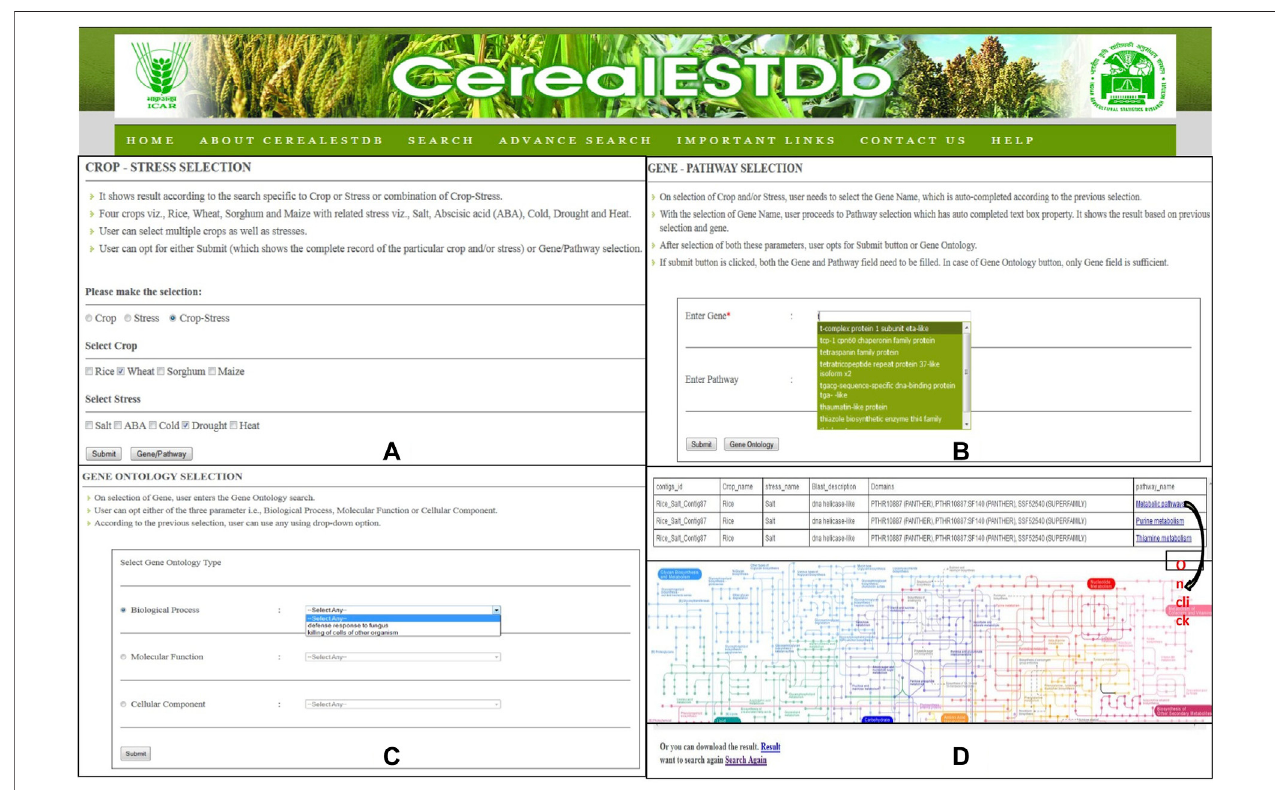
FIGURE 6 | Details of Search Options in CerealESTDb (A) Crop-Stress Selection page with options of select either crop or stress or combination of both (B) Gene-Pathway Selection page with mandatory fi eld Gene and optional fi eld Pathway (C) Gene Ontology Selection page, to select either of the three options of BiologicalProcessorMolecularFunctionorCellularComponent (D) FinalResultpageaftergoingthroughallthethree